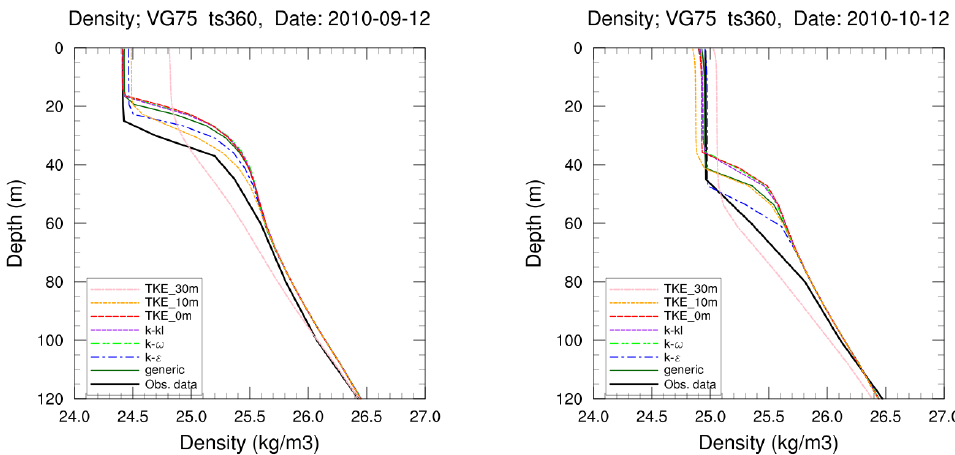
Figure 9. Daily vertical profiles of density during the stratified period (12 September 2010) on the left and at the beginning of the delayering period (12 October 2010) on the